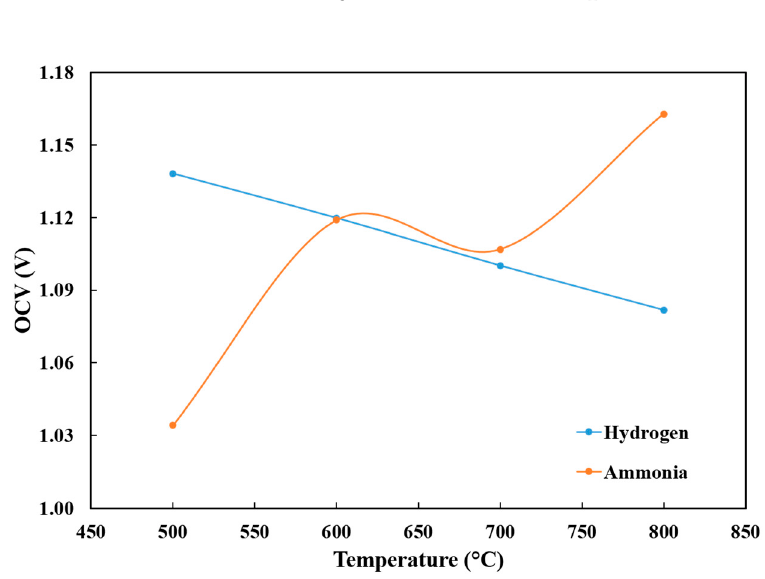
Figure 6. Experimental OCV of Ag-LSCF//YSZ//GDC/LSCF cell with dry hydrogen and ammonia fuels as a function of temperature.